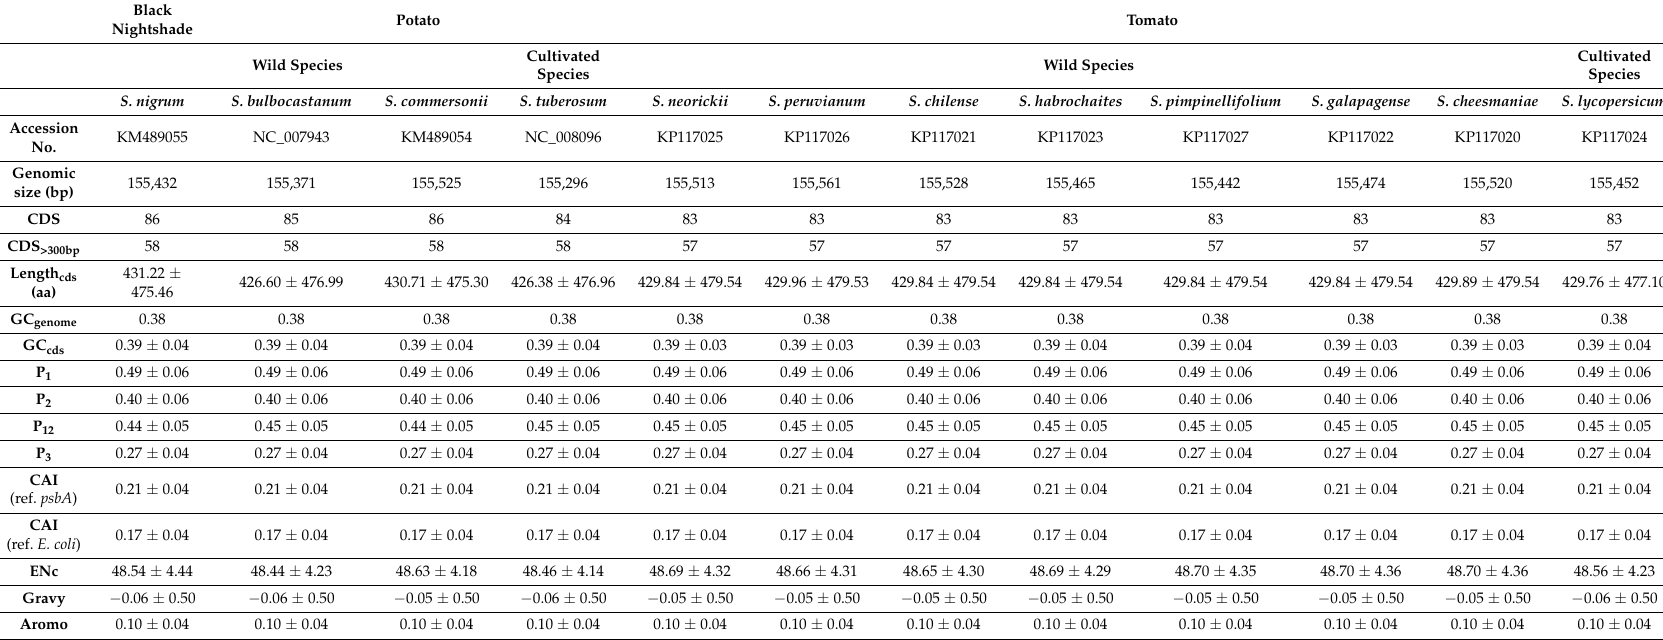
Table 1. Genomic features of twelve Solanum chloroplast